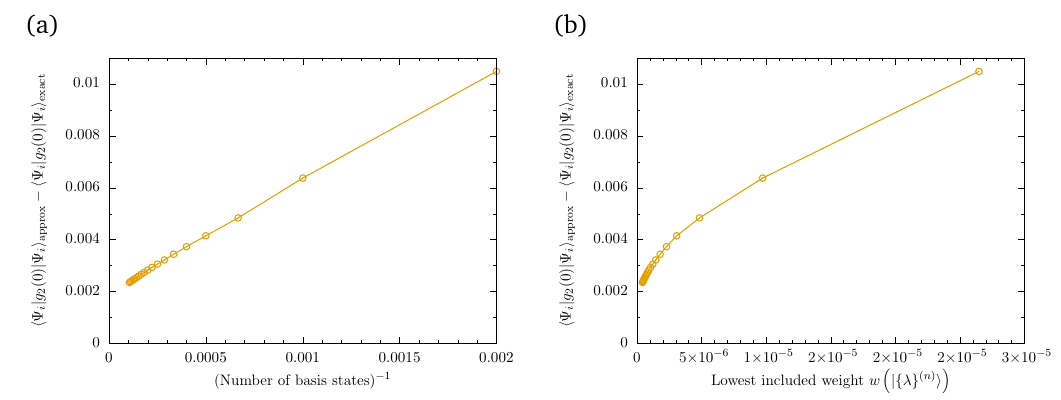
( 0 ) in the con- 2 = 10 eigenstates) and f